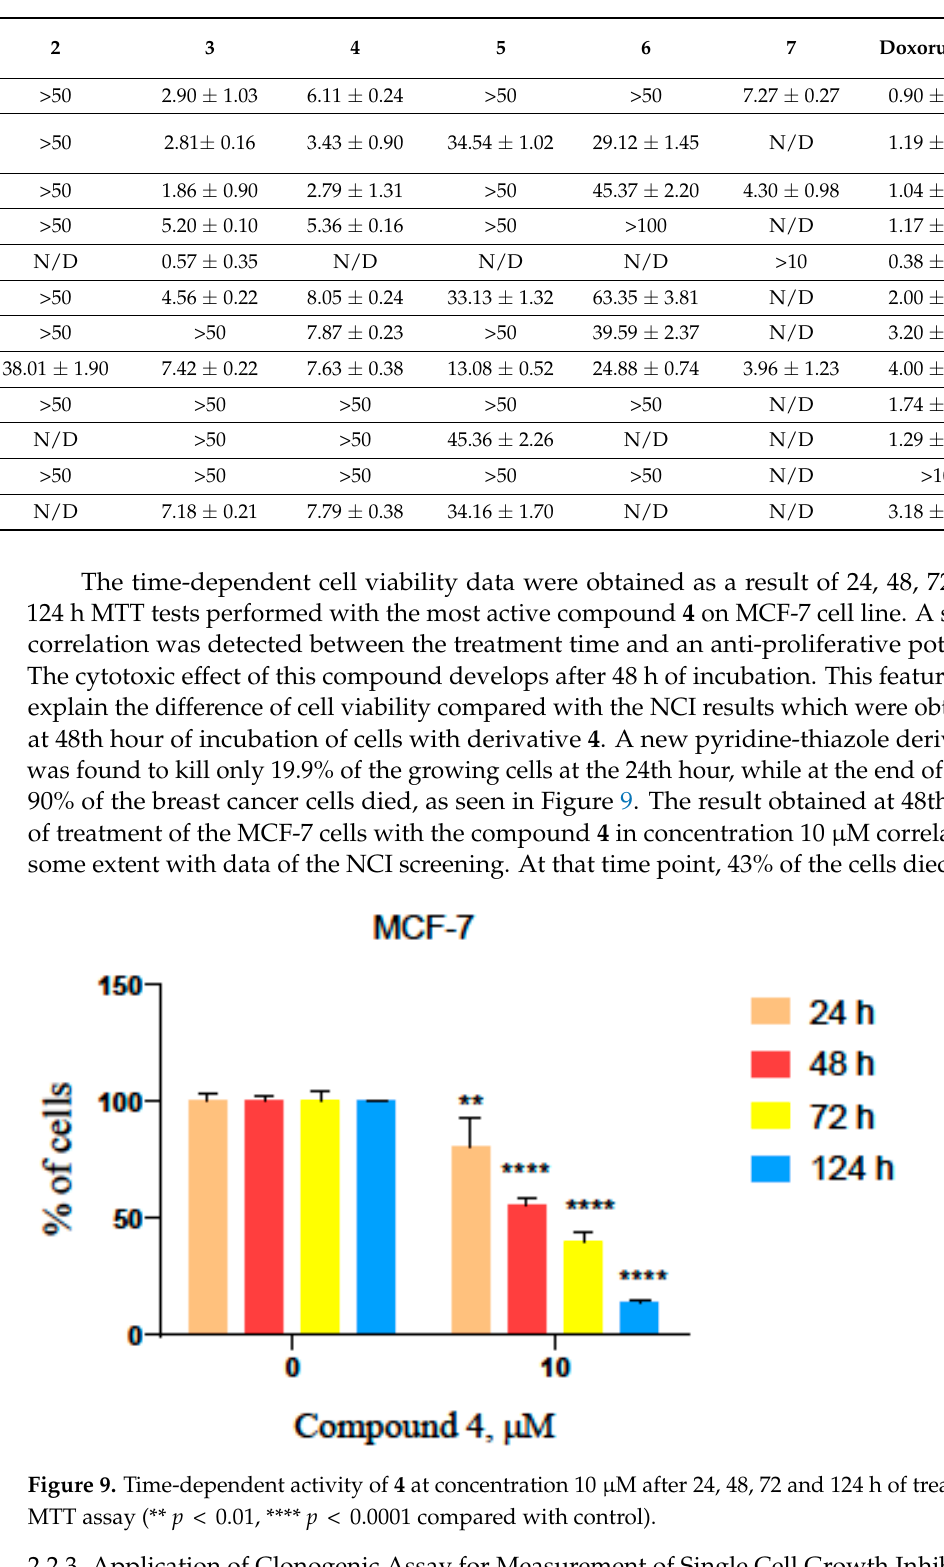
Molecules 2022 , 27 , x FOR PEER REVIEW 11 of 30 Table 5. The IC 50 values of screened compounds towards a panel of tumor and pseudo-normal cell lines. N/D—not determined (72 h of incubation, µM, M ± SD).